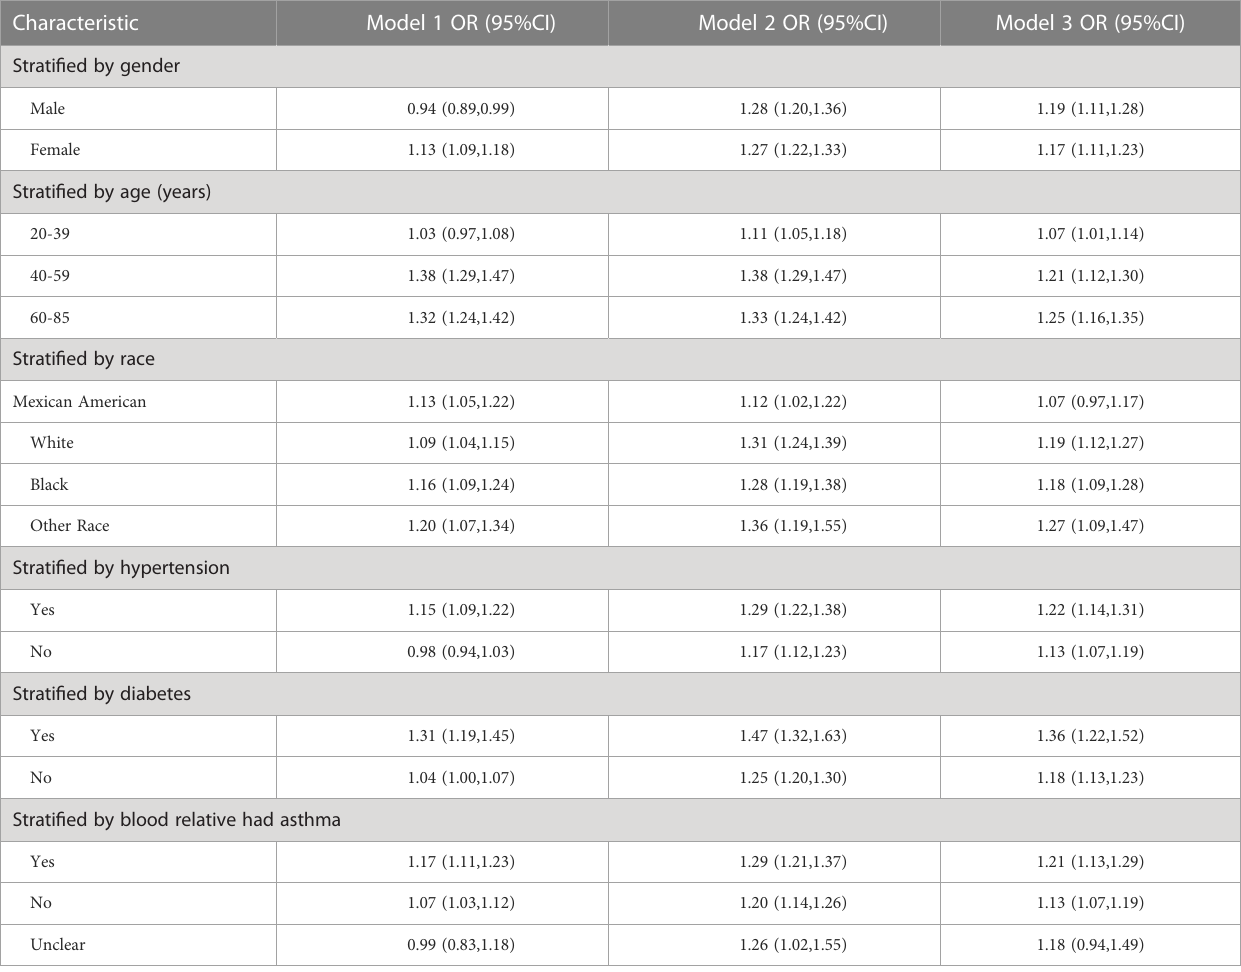
TABLE 3 Subgroup analysis between WWI index with asthma